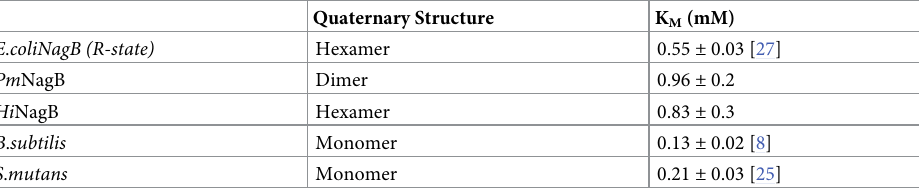
Table 3. Comparison of quaternary structure and the K M of different